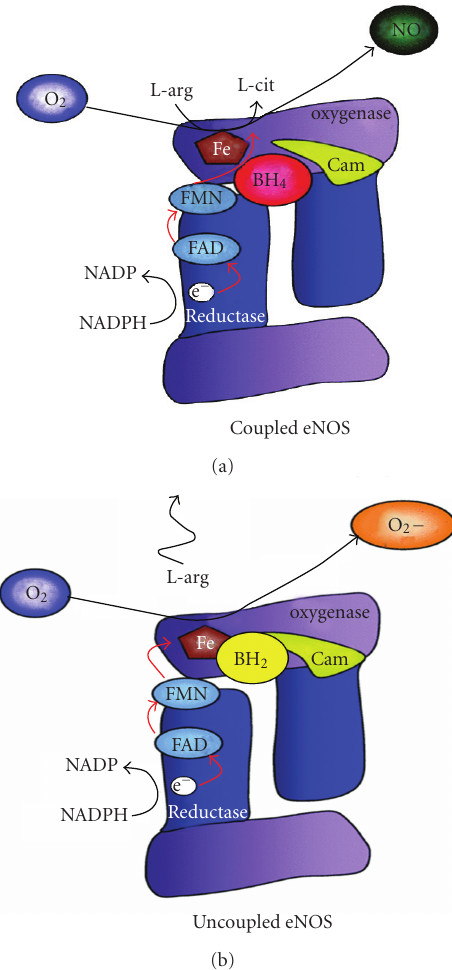
Figure 9: Schematic diagram of eNOS coupling and uncoupling. BH 4 binds to the heme oxygenase domain to promote L-arginine substrate binding under eNOS coupling conditions. By contrast, BH 2 competes with BH 4 at the heme oxygenase domain and promotes molecular oxygen as substrate to produce superoxide and eNOS uncoupling conditions (Adopted from